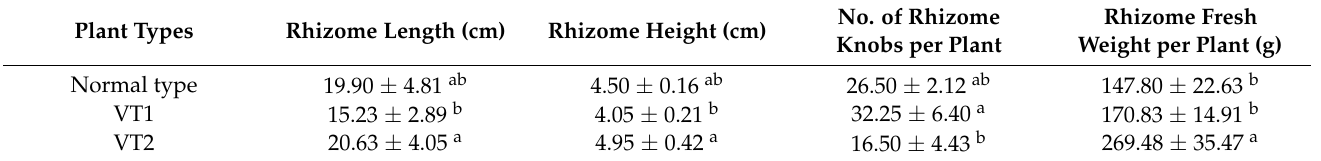
Table 4. Main yield traits of the normal-type ginger and the two variation types at harvest.